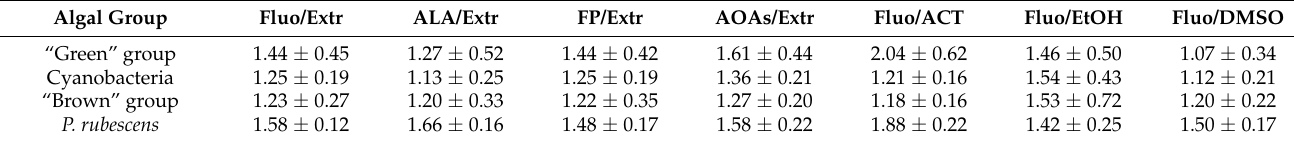
Table 2. Ratios of mean Chl- a concentrations ( µ g L − 1 ) measured by spectrofluorometers and extraction determinations for each target algal group. Fluo = mean of in vivo fluorescence determinations; Extr = mean of extracts. Determinations performed with the four models of AOAs are grouped